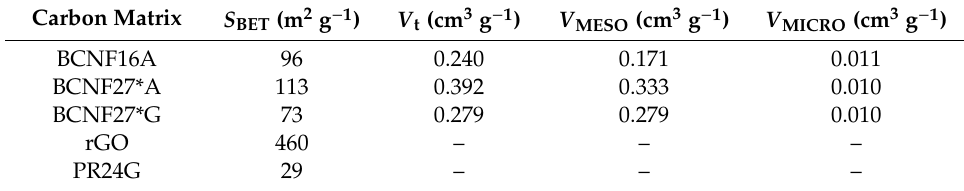
Table 2. Textural parameters of carbon matrices: BET surface area ( S BET ), Total N 2 pore volume ( V t ), mesopore volume ( V MESO ) and micropore volume ( V MICRO